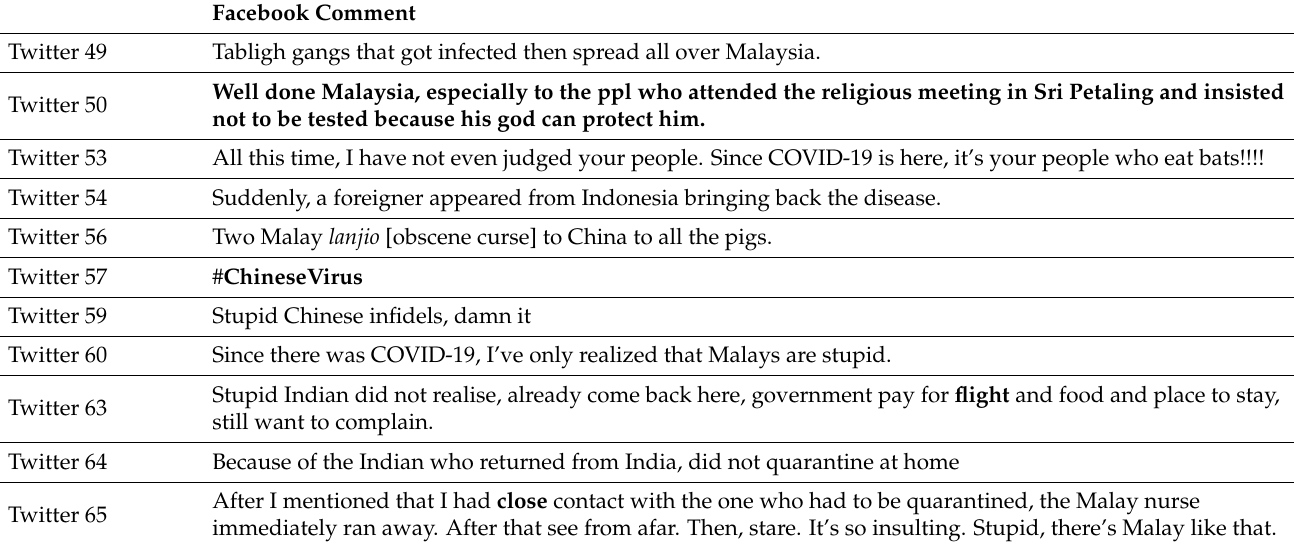
Table 5. Examples of ethnicity-related stigmatization of COVID-19 patients in tweets (N = 17).